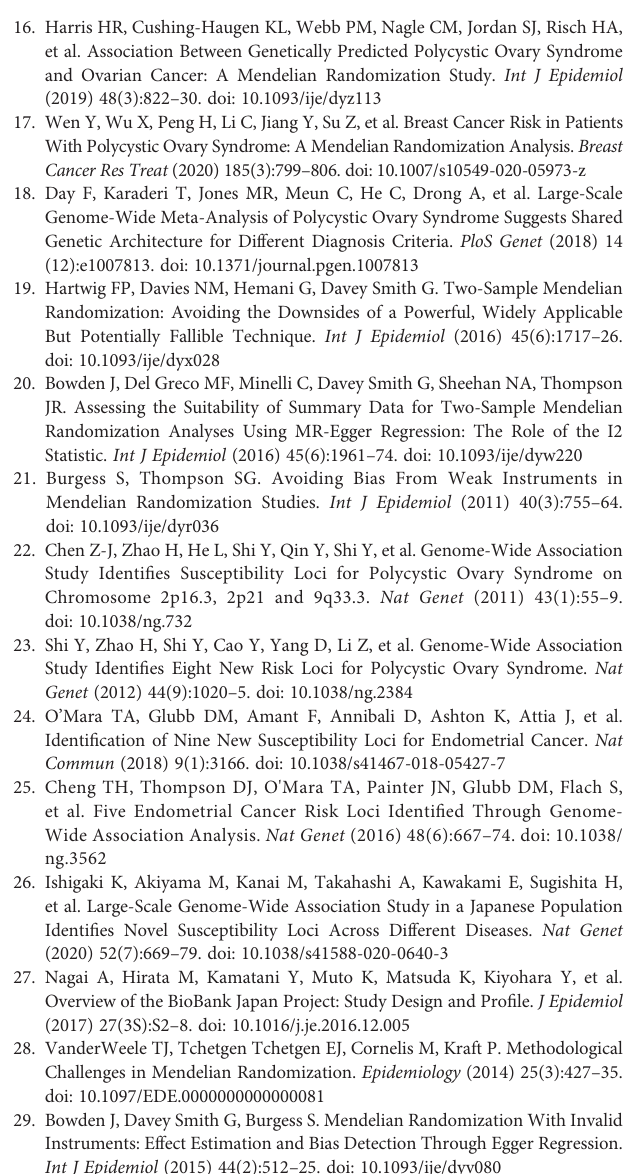
Supplementary Figure 1 | Scatter plot of PCOS on endometrial cancer: (A) scatter plot of PCOS on endometrial cancer in Asians; (B) scatter plot of PCOS on overall endometrial cancer in Europeans; (C) scatter plot of PCOS on endometrioid endometrial cancer in Europeans; (D) scatter plot of PCOS on non-endometrioid endometrial cancer in